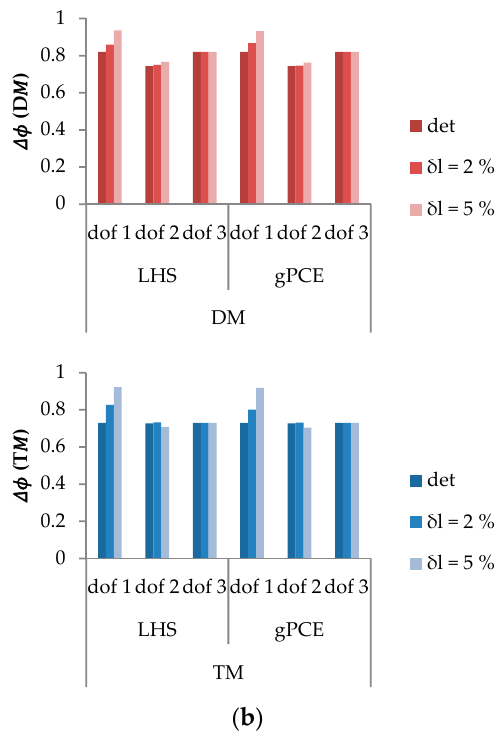
Figure 16. Evolution of ( a ) the frequency ranges and ( b ) the amplitude ranges of the multistability domain with respect to deterministic ones according to the DM and TM. Table 4. Stochastic amplitude and frequency ranges of the multistability domain, according to the DM and TM, with respect to the deterministic ranges.